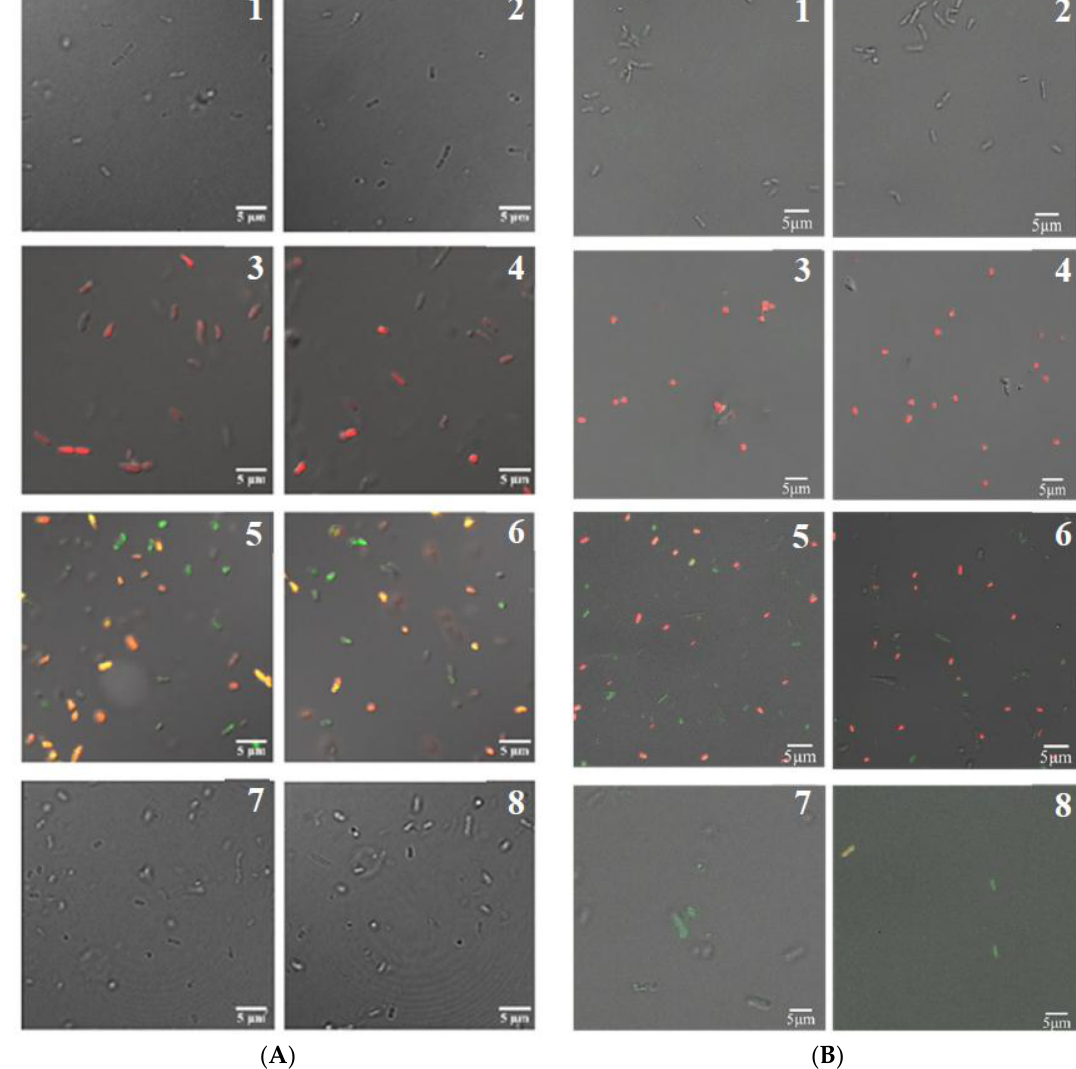
Figure 4. Typical transconjugants with plasmid RP4:: gfp in gene transfer system: ( A ) the system with sole recipient (Tests 5# and 7#), ( B ) is the system with multi-recipient (Tests 6# and 8#), 1, 2: recipient, 3,4: donor, A5,A6: gene transfer in Test 7#, B5,B6: gene transfer in Test 8#, A7,A8: gene transfer in recipient flask of U-tube in Test 5#, and B7,B8: gene transfer in recipient flask of U-tube in Test 6#. Bars, 5 μm.